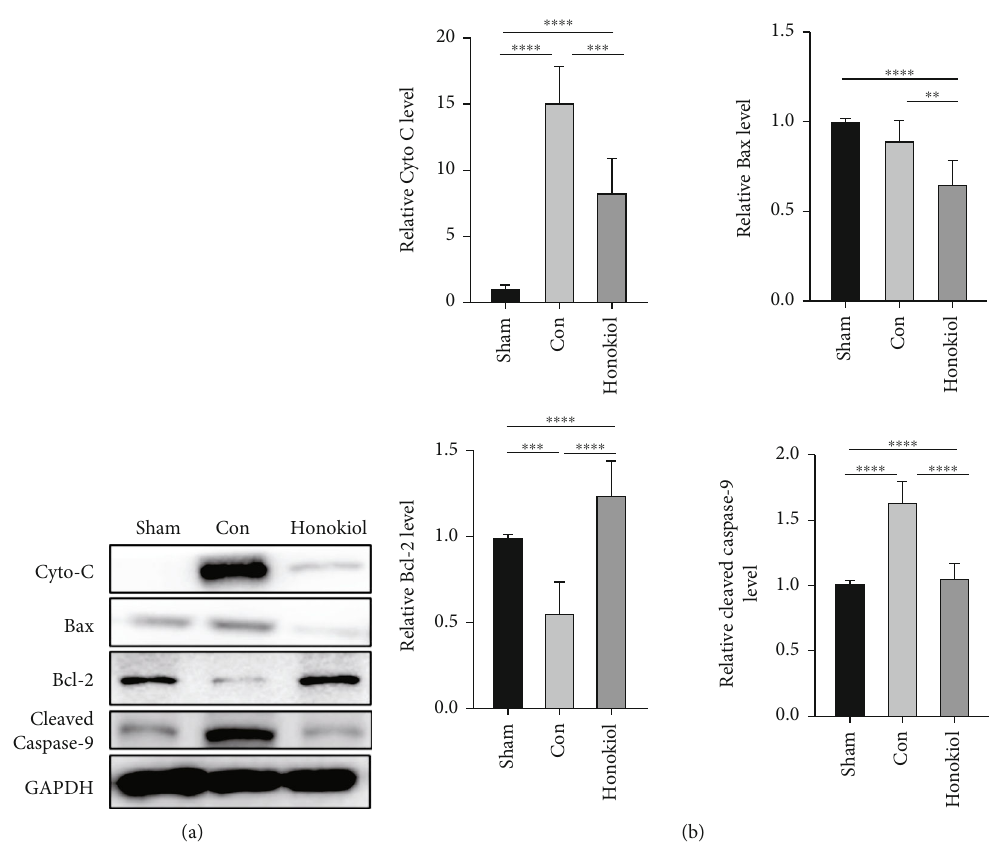
Figure 6: Western blot analysis of apoptosis-associated proteins. Western blotting was utilized to evaluate the protein levels of cleaved caspase-9, Cyt-C, Bcl-2, and Bax. GAPDH acted as the internal reference ( n = 6 for each cohort). Data are articulated as mean ± SEM . ∗ ∗ p < 0 : 01 ; ∗∗∗ p < 0 : 001 ; ∗∗∗ ∗ p < 0 : 0001